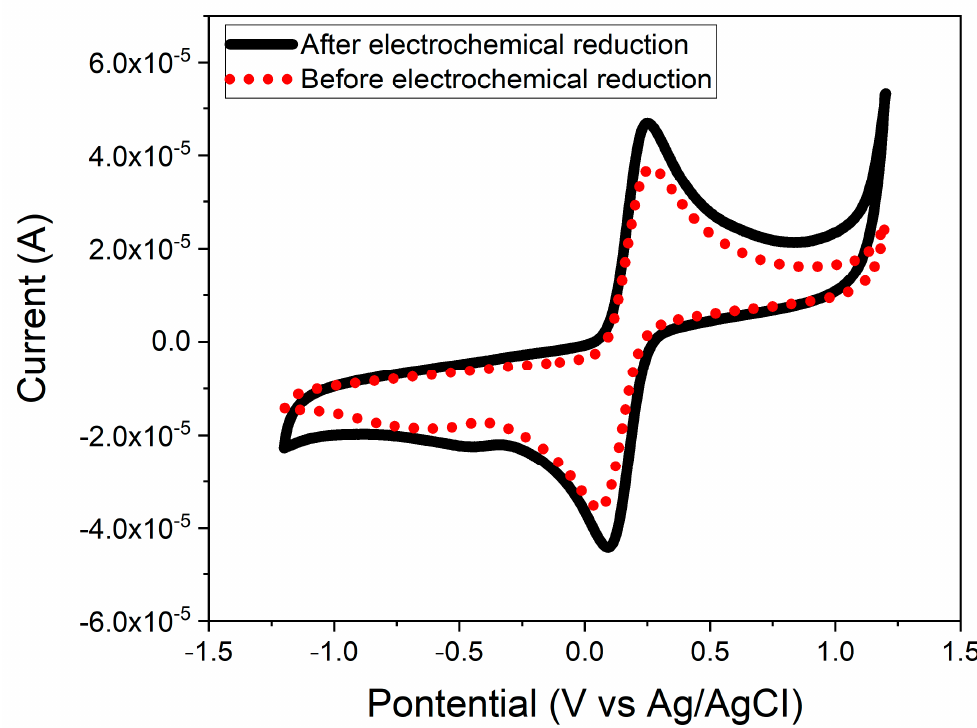
Figure 6. CV responses of the CeNP / GO composite before and after electrochemical reduction in a 0.1 M phosphate buffer solution (PBS, pH 7.2) containing 5 mM of [Fe(CN) 6 ] 3 − /4 − and 0.1 M KCl with 100 mV / s of scan rate.